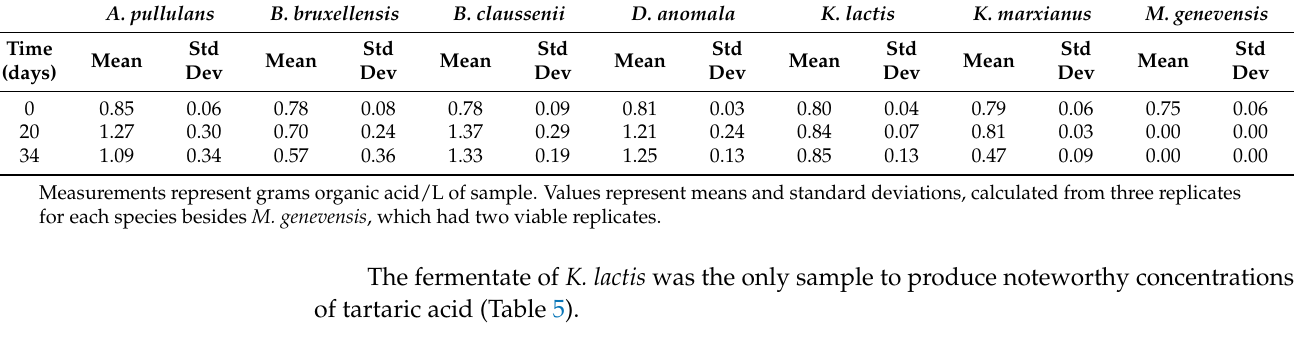
Table 5. Tartaric acid concentrations under anaerobic fermentation (g/L).